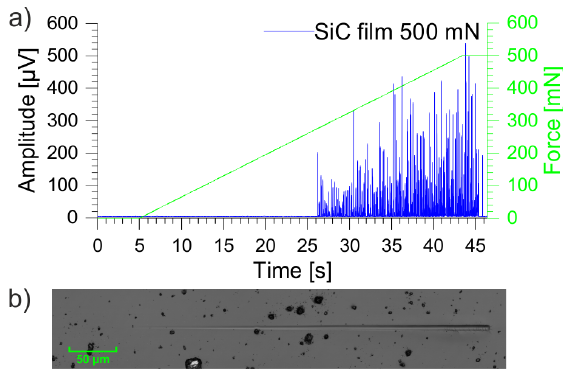
Figure 3. Scratch test performed up to 500 mN on SiC thin film: a) AE envelope b) residual scratch groove.